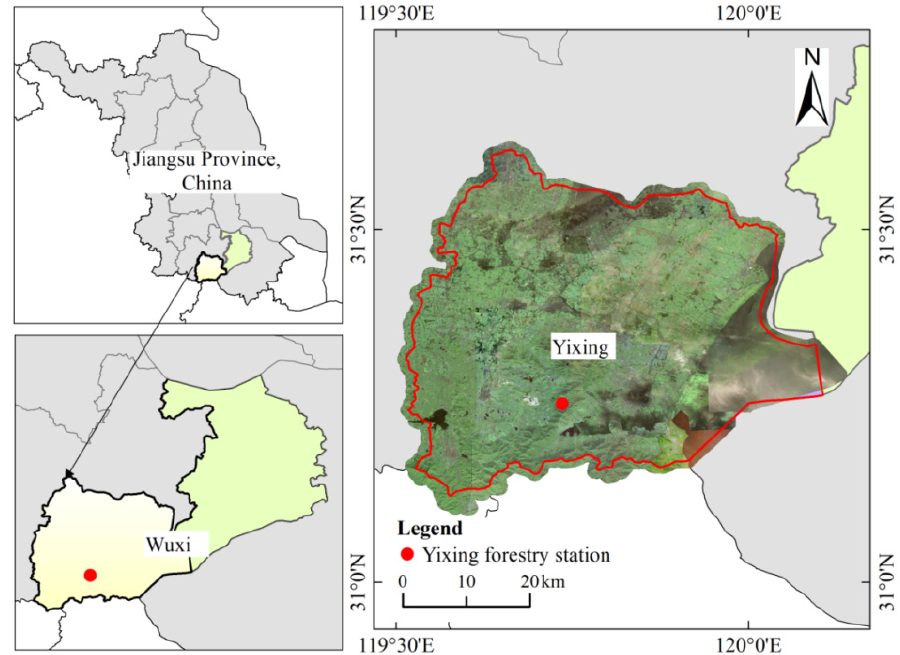
Figure 1. Location of the study area.